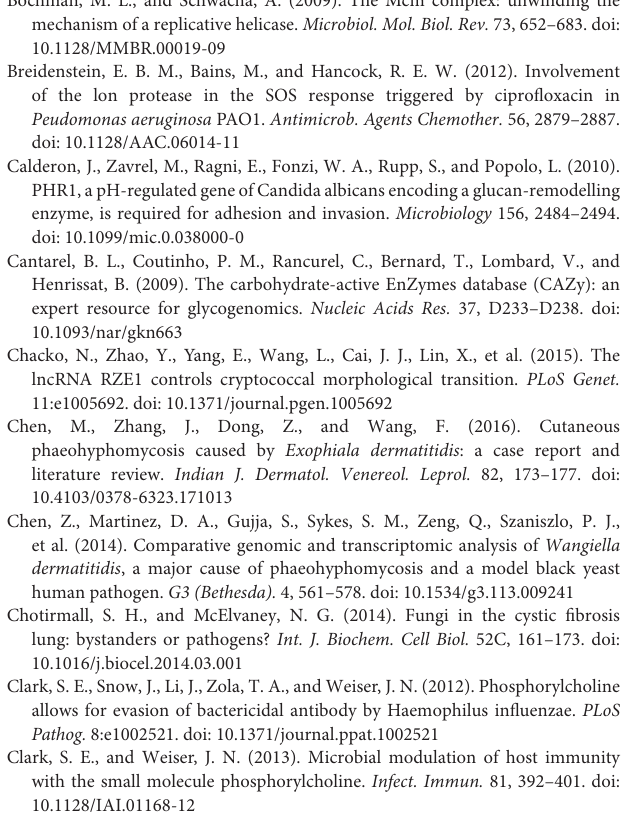
(Black spot in the middle). Supplementary Figure 2 | Similarity assessment of the RNA sequencing runs with principal component analysis. The clustering pattern fits well with the expectation from the experimental design. Supplementary Table 1 | Summary of all results and raw